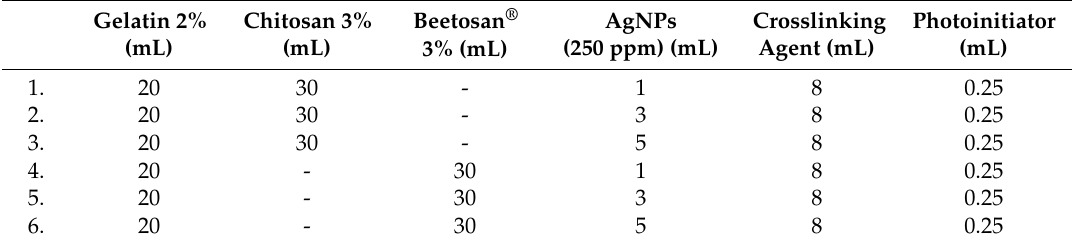
Table 3. Compositions of prepared